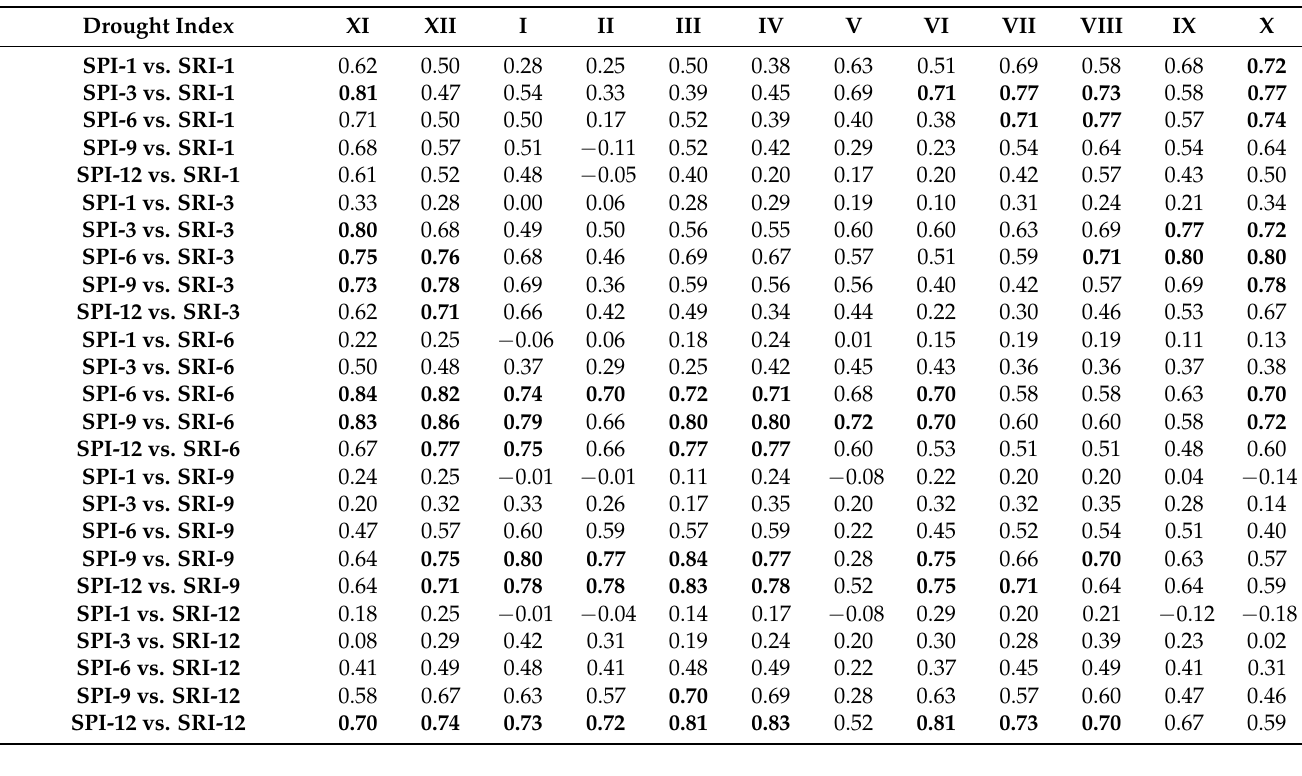
Table 9. Correlation coefficients between the meteorological drought and hydrological drought using the SPI for Medzi- laborce vs. the SRI for